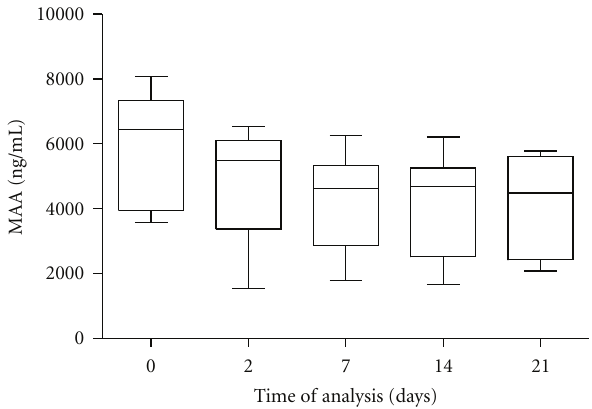
Figure 2: Concentrations of M-SAA in milk samples during freezer storage. The plots show the median (line within box), 25th and 75th percentiles (box), and minimum and maximum values (whiskers).